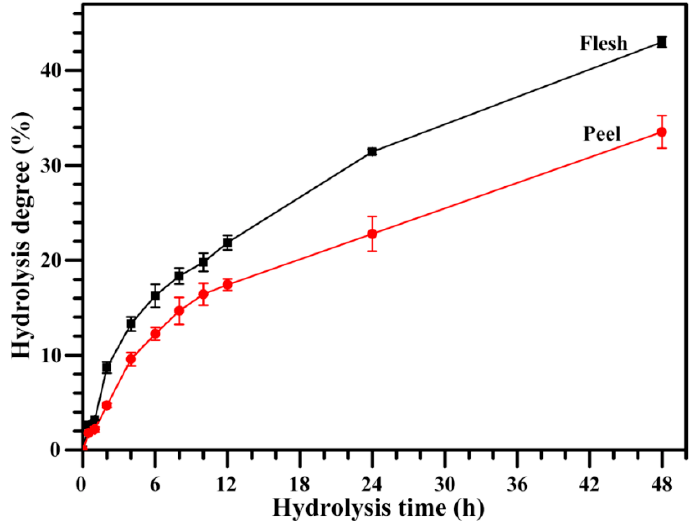
Figure 8. Hydrolysis curves of starches by porcine pancreatic α -amylase (PPA).